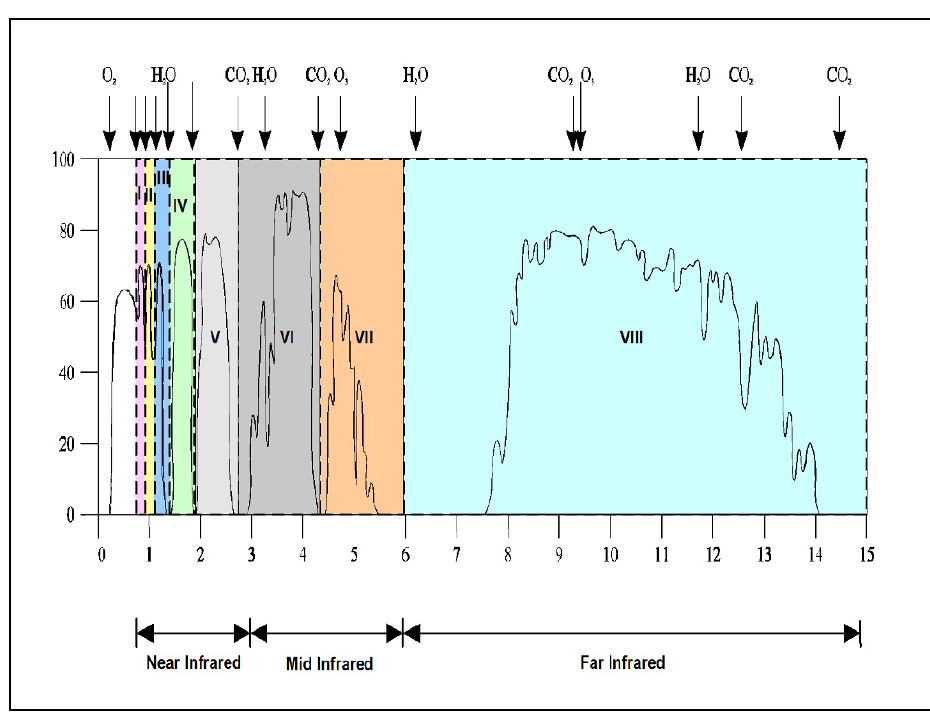
Figure 2. Sea-level transmittance over a 1820 m horizontal path. Adapted from